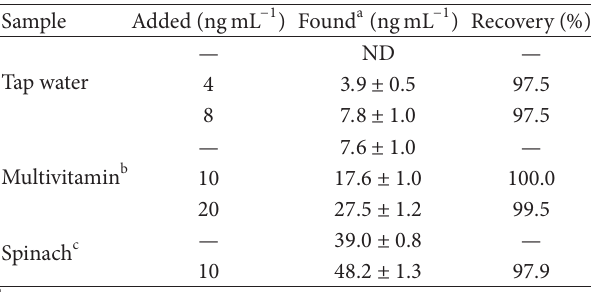
T 3: Determination of iron (II) in different